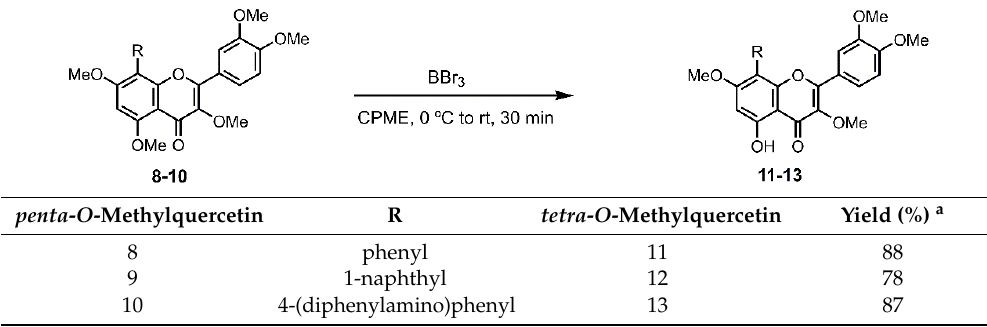
Table 1. Synthesis of 3,7,3 ′ ,4 ′ - tetra - O -methylquercetins ( 11 – 13 ).